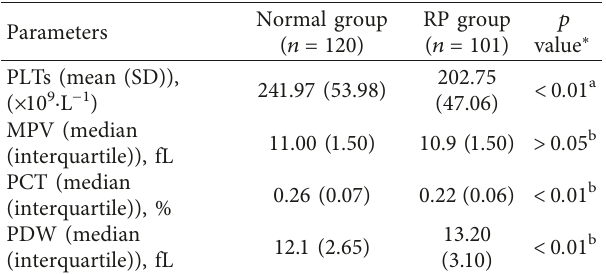
∗ p < 0 . 05 was considered statistically significant; ∗∗ p < 0 . 01 was considered statistically very significant; a T test was used to analyze the data; b rank sum test was used to analyze the samples.